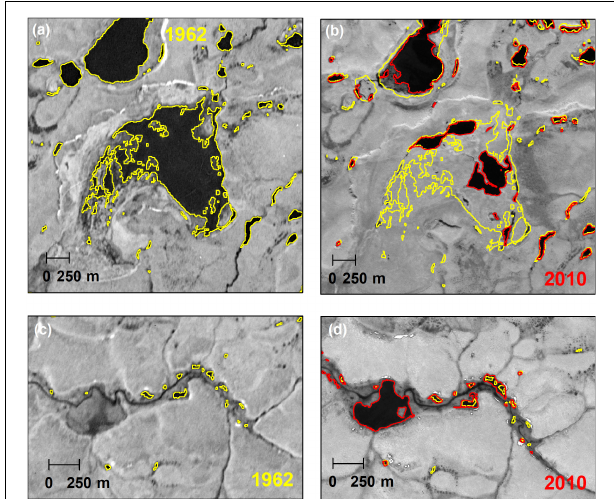
FIGURE 7 | Temporal changes of waterbody sizes in the Shishmaref area in the Kotzebue Sound Lowlands (study region #1) of the Seward Peninsula, Alaska. Waterbody outlines are marked in yellow for 1962 and in red outlines for 2010: (a) and (b) illustrate complete and partial drainage of waterbodies, while (c) and (d) illustrate waterbody formation and